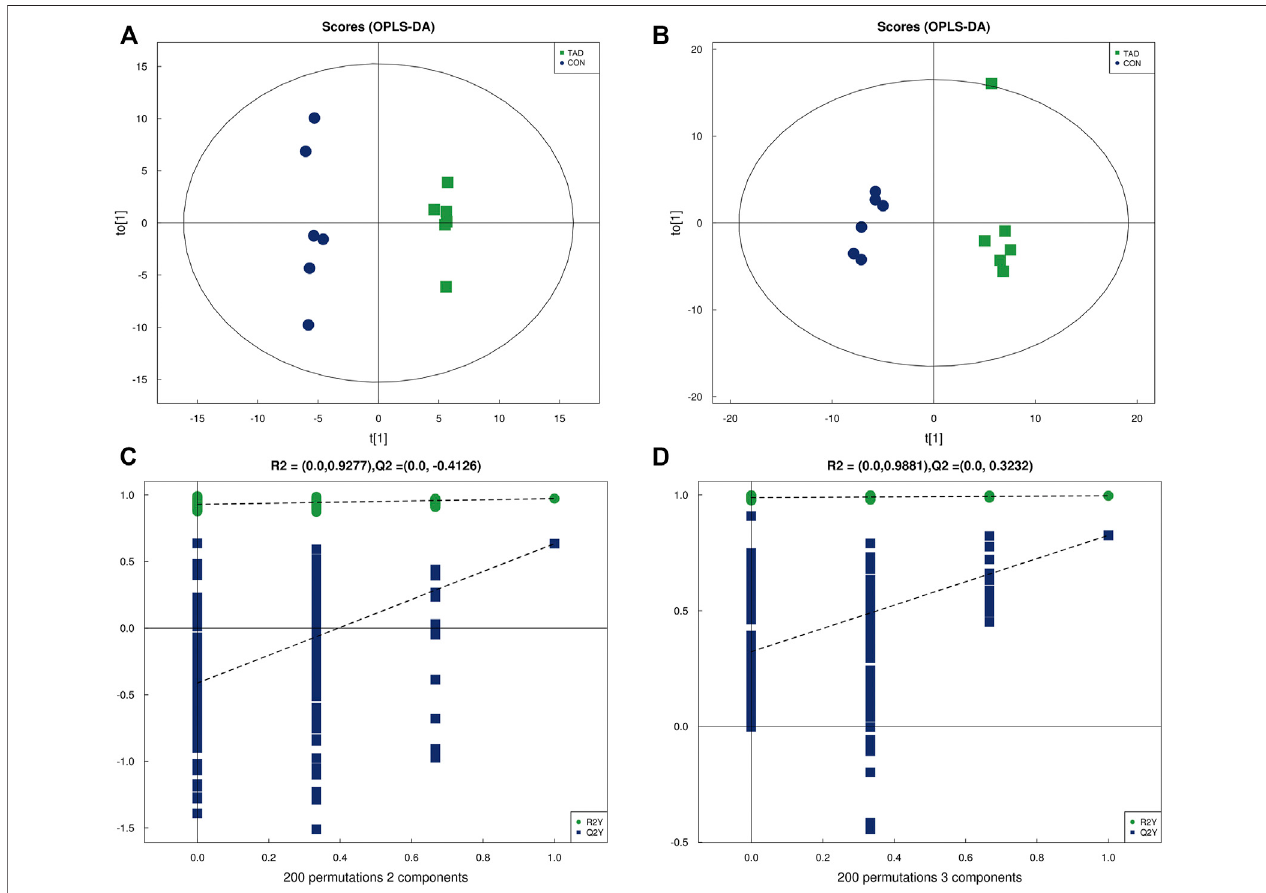
FIGURE 4 | OPLS-DA analysis of alterations in the metabolite pro fi le. (A) OPLS-DA score plot derived from metabolite ions acquired using the ESI+. (B) OPLS-DA score plot derived from metabolite ions acquired using the ESI-. (C,D) Permutation test for OPLS-DA in positive and negative ion mode. OPLS-DA, orthogonal partial least-squares discriminant analysis; ESI+, electrospray ionization positive ion mode; ESI-, electrospray ionization negative ion